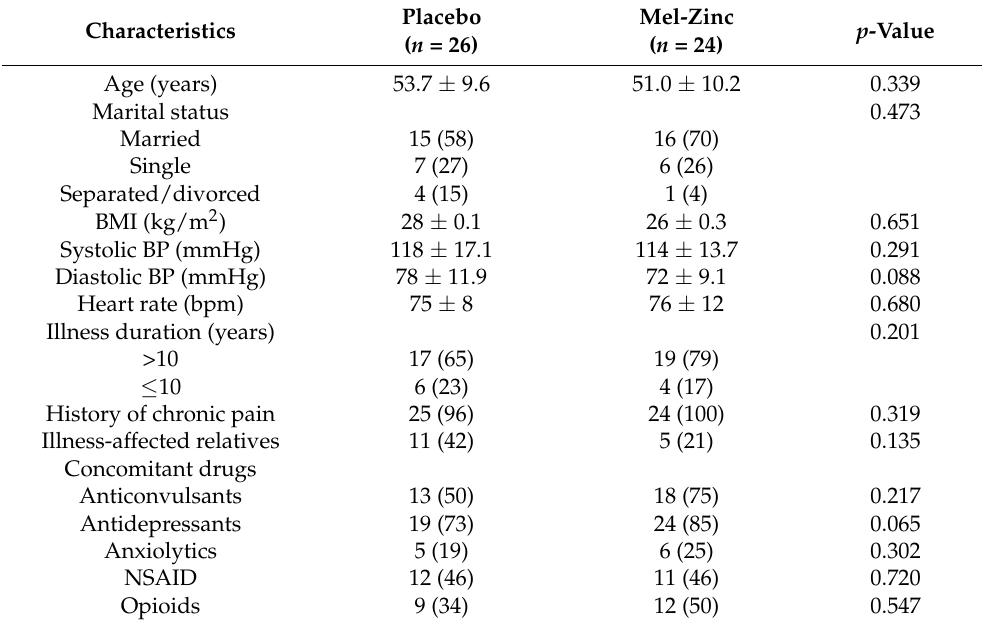
Table 1. Baseline demographic and clinical characteristics of study participants who completed the final